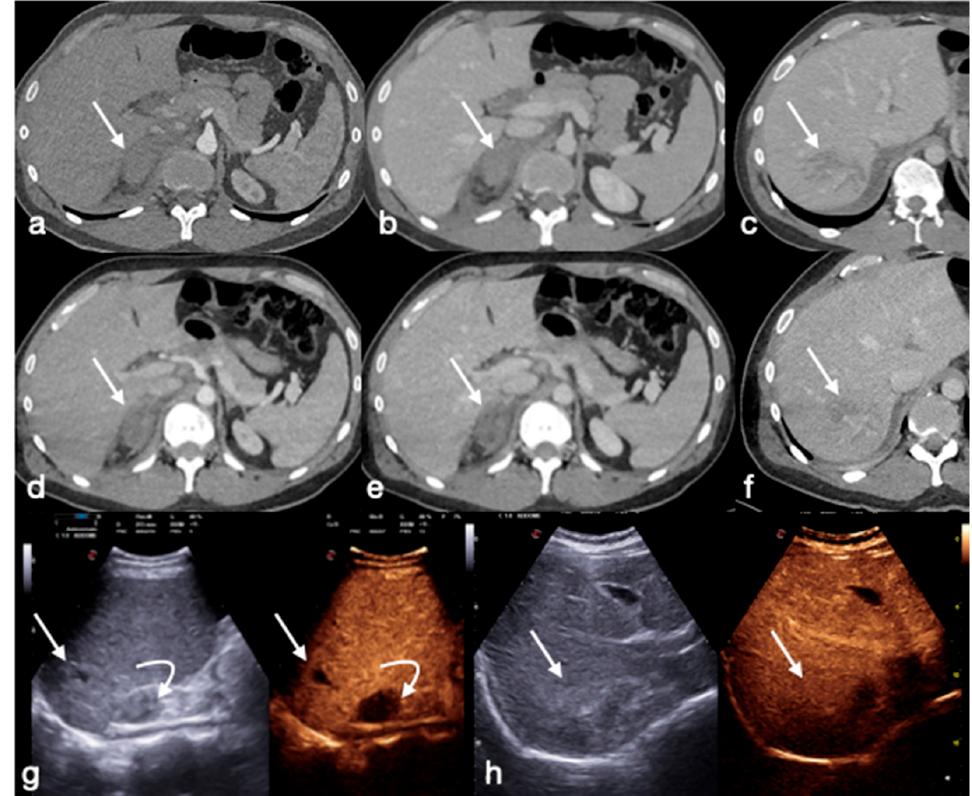
Figure 8. Thirty-five-year-old male patient with right adrenal hematoma and liver laceration after blunt trauma: ( a – c ) admission enhanced CT in arterial ( a ) and venous phases ( b , c ) showing the adrenal hematoma (AAST V; ( a , b ) arrows) and the liver laceration (AAST II, ( c ) arrow). ( d – f ) Follow-up CT performed five days after trauma, showing stable findings (( d , e ) adrenal hematoma, arrows; ( f ) liver laceration, arrow). Subsequently, the patient underwent CEUS examination ( g , h ) demonstrating the progressive healing of the liver laceration (( g , h ) straight arrows) and the slow resorption of adrenal hematoma (( g ) curved arrow).